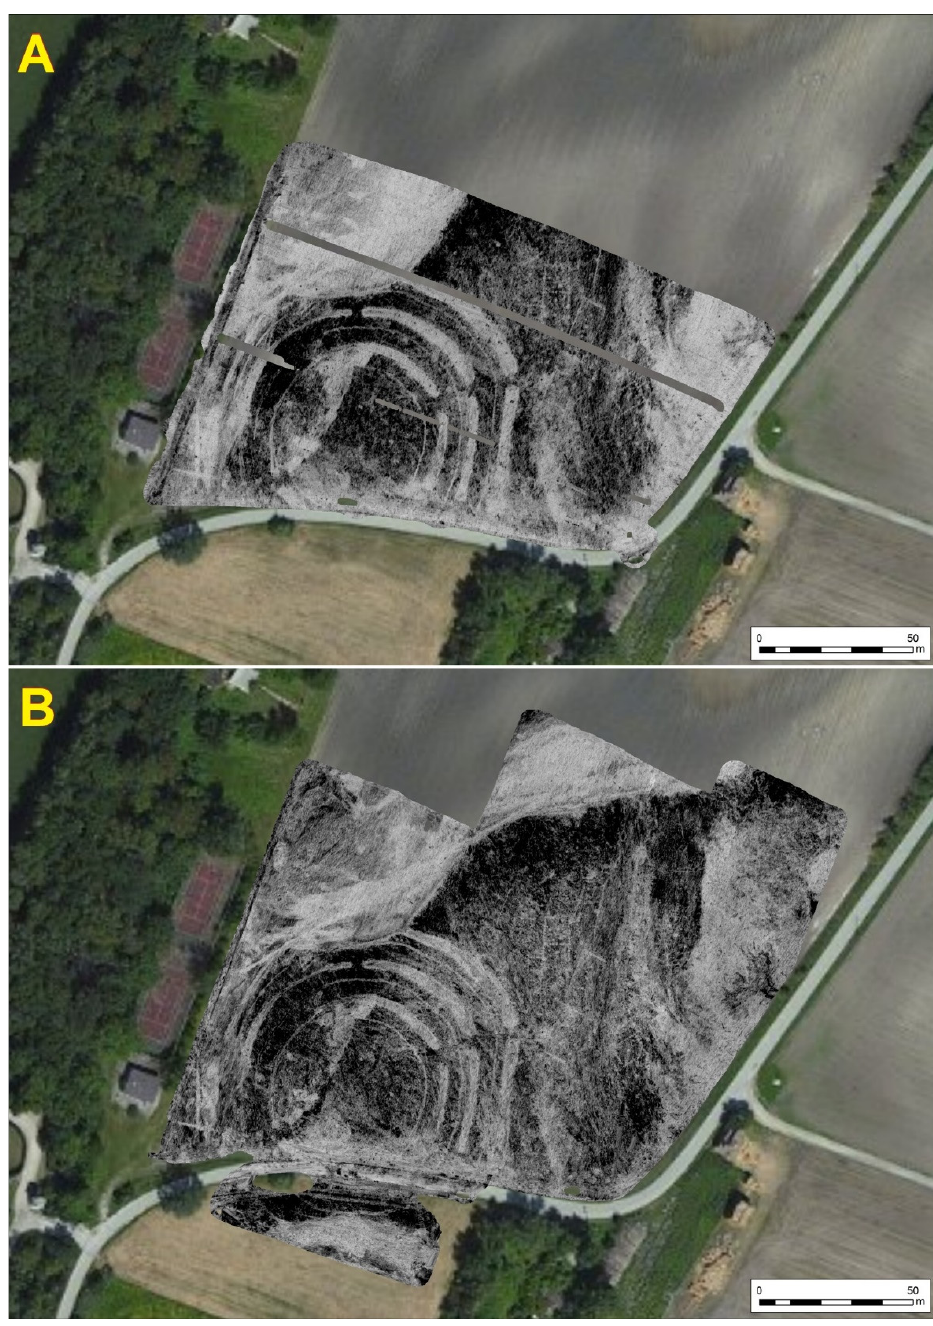
Figure 7. Comparison of the two GPR surveys at Velm: ( A ) the motorized GPR survey with a 6-channel Sensors and Software SPIDAR 500 MHz, and ( B ) the motorized GPR survey with a 16-channel 400 MHz B ) the motorized GPR survey with a MIRA system from Malå (both showing a calculated depth range of 60 to 120 cm). 6-channel Sensors and Software SPIDAR 500 MHz, and ( 16-channel 400 MHz MIRA system from Malå (both showing a calculated depth range of 60 to 120